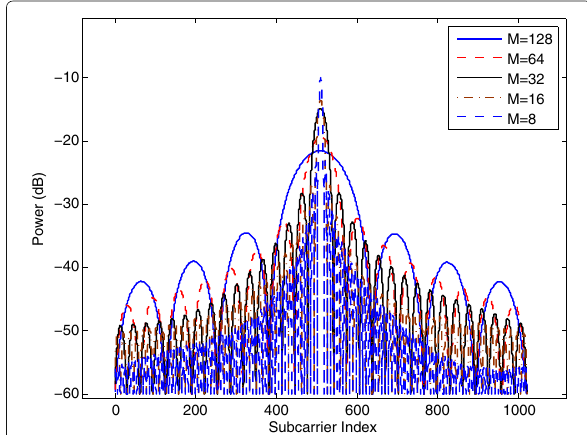
Fig. 2 The power comparison of the desired subcarrier and other interfering subcarriers with the midpoint model with d = 511, N s = 1024, and F d T s =